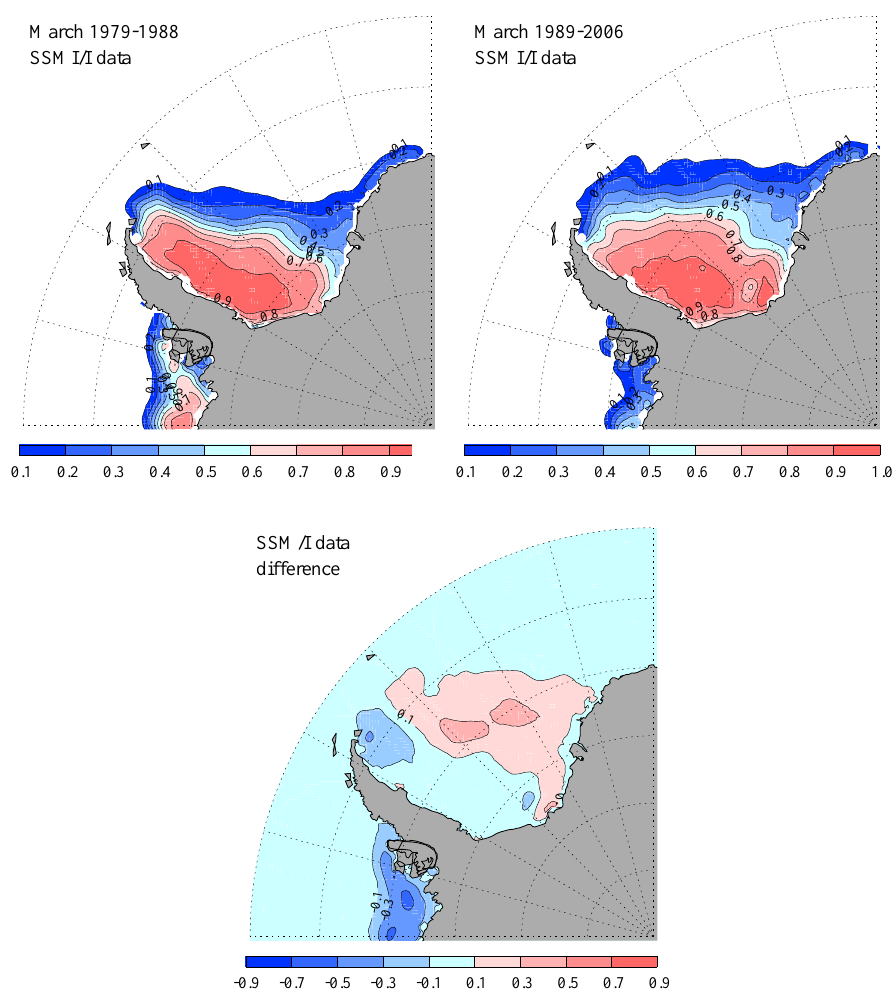
Fig. 9. SSMI/I derived decadal mean summer (March) sea ice concentration [%] for the periods 1979–1988 (upper left) and 1989–2006 (upper right) for the sector 0 ◦ –90 ◦ W of the Southern Ocean. The diffence between both periods (lower panel) shows sea ice concentration being most reduced (up to 50%) on the continental shelf off the tip of the Antarctic Peninsula.